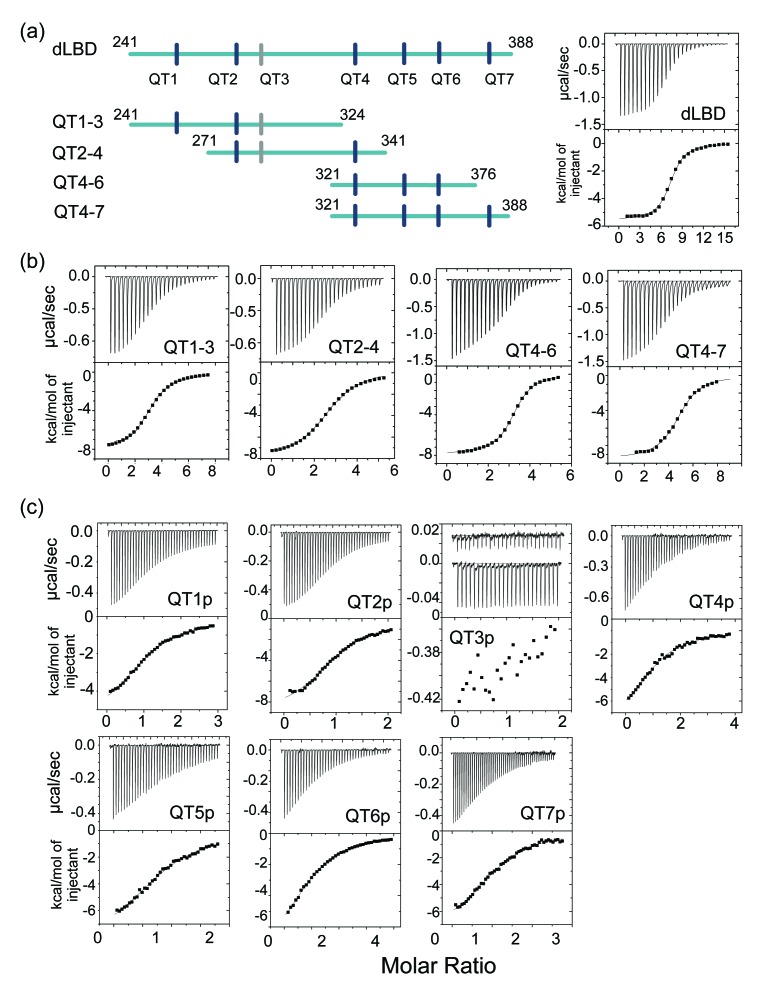
LC8-dLBD interactions monitored by ITC.(a) Construct schematics of the dLBD, QT1-3, QT2-4, QT4-6, and QT4-7 are shown, along with the locations of each TQT motif. A representative isothermal titration calorimetry thermogram of LC8 with the dLBD is shown on the right. (b) Representative thermograms of LC8 with constructs corresponding to QT1-3, QT2-4, QT4-6, and QT4-7. (c) Representative isothermal titration plots of LC8 with peptides corresponding to QT1p, QT2p, QT3p, QT4p, QT5p, QT6p, and QT7p. Since the interaction with QT3p is too weak, the heat exchange with buffer is plotted on top to show the difference between QT3p with LC8 and buffer. Higher concentrations were not possible due to poor solubility of the QT3p. Data were fit to a single site binding model using Origin software.